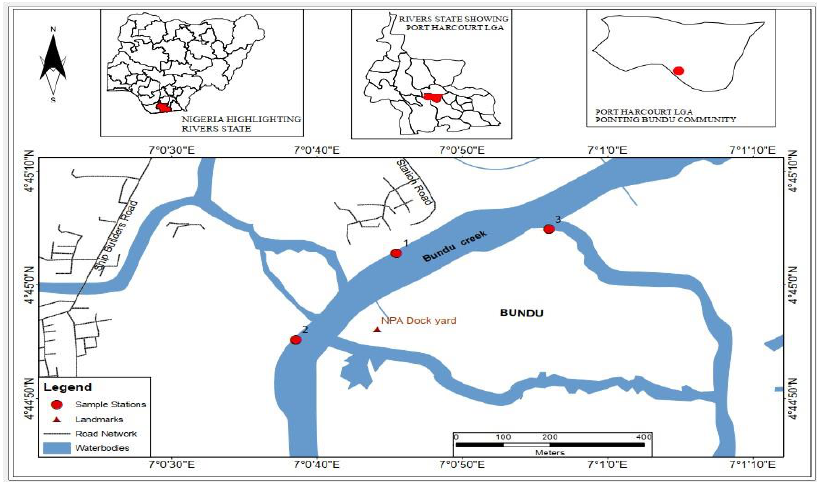
Figure 1. Section of the Isaka–Bundu Creek sampled and studied.